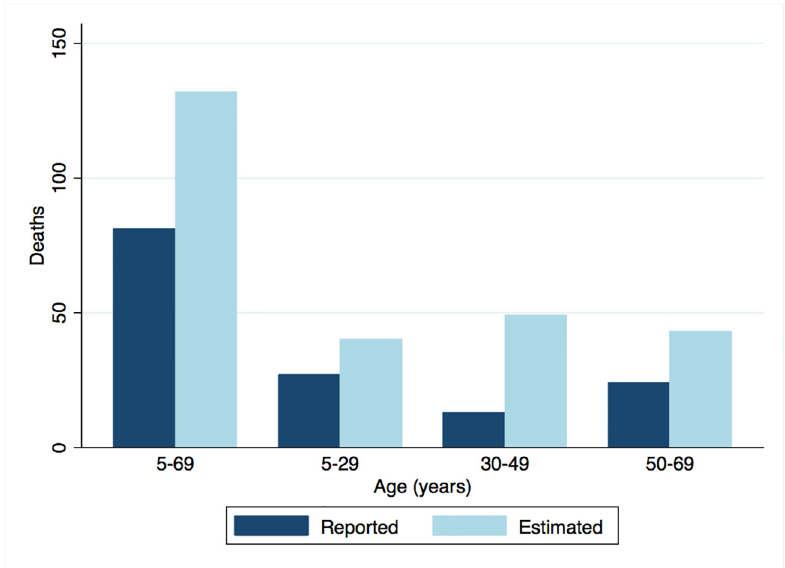
Fig 4. Reported and estimated RHD-attributable deaths by age in Fiji, 2011 – 2012. Reported counts are derived from ICD10 coding of underlying cause-of-death classifications in vital registration data. Estimated counts are based on excess deaths in the